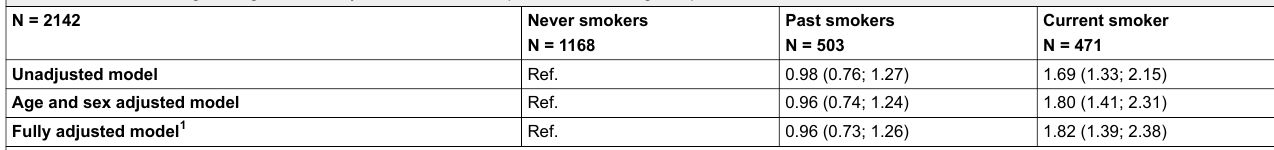
Table 2: Multivariable logistic regression analysis of the relationship between smoking and pre-diabetes. N =